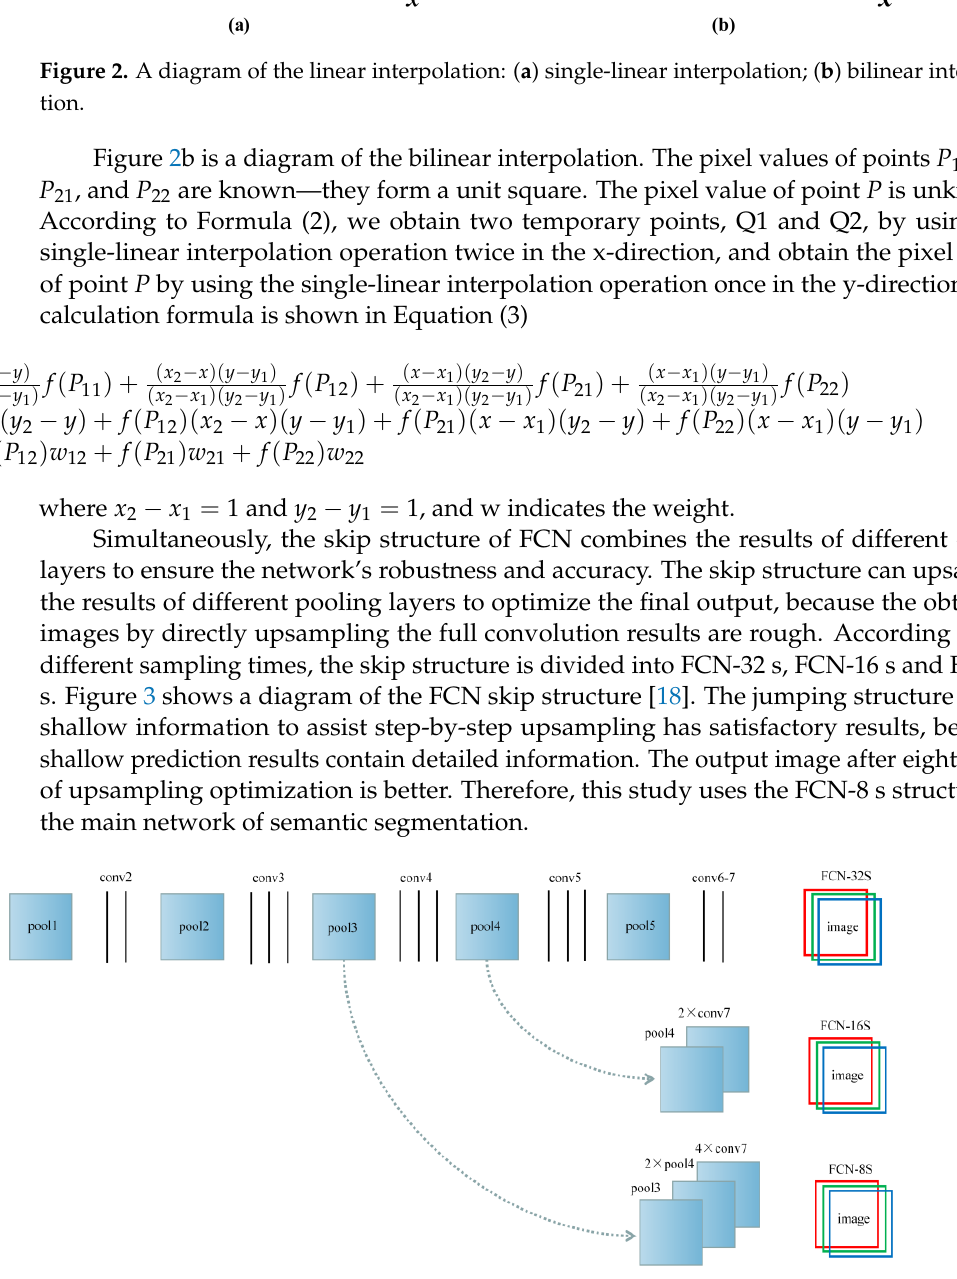
Figure 3. A diagram of the fully convolutional network (FCN) skip structure.